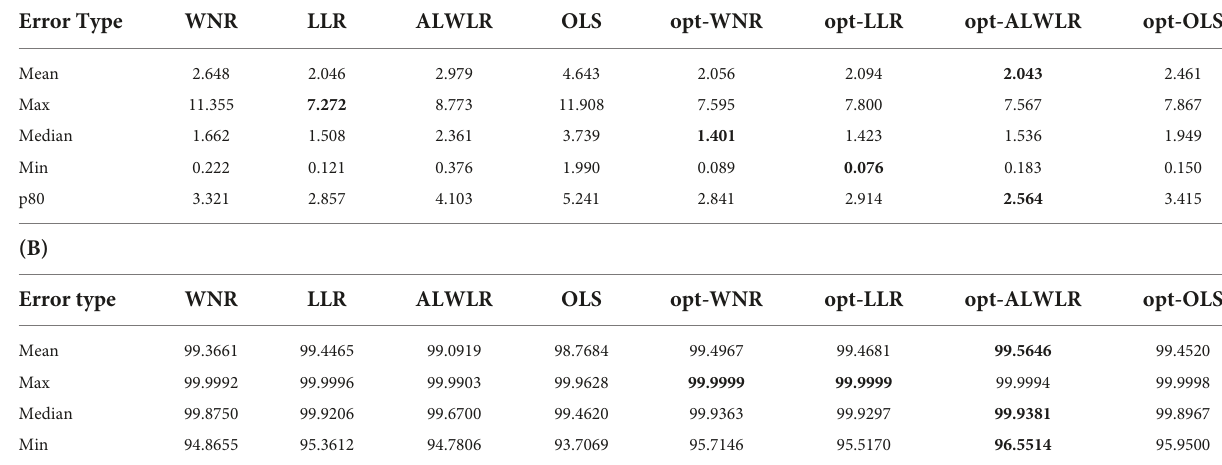
TABLE 7 Comparison of the estimation accuracy of four methods applying the weighting strategy: (A) RMSE, (B) GFC, (C) (cid:49) E ∗ ab , and (D) (cid:49) E 00 .